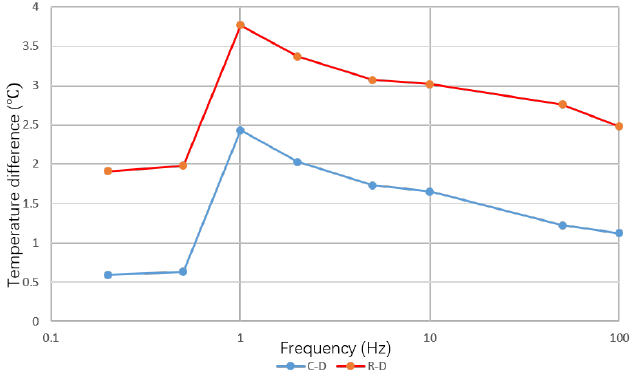
Figure 14. Temperature difference between cooling systems and reference against sweeping